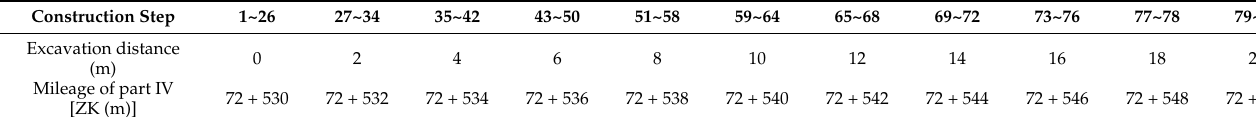
Table 4. Excavating distance and mileage of part IV corresponding to each construction step.